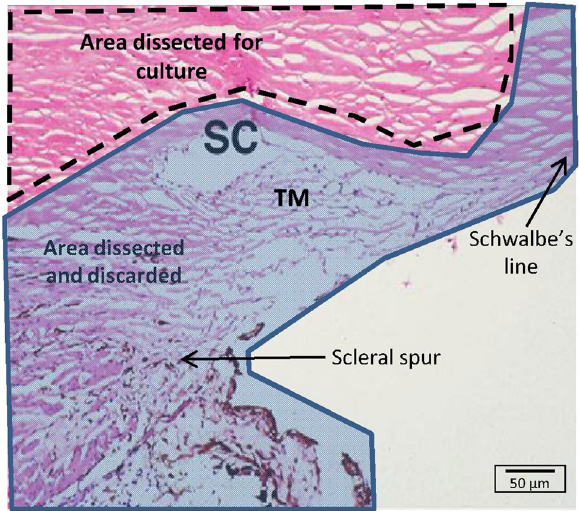
Figure 1. Establishing primary cultures of VDOP cells. Image showing the region of the conventional outflow pathway that was dissected and removed (lightly shaded portions), and the portion isolated (dotted area) for extracting VDOP cells. The extracted tissue rims were cut into 1–2 mm pieces, incubated in collagenase for 90 min and immersed in low glucose DMEM containing 10% FBS and 1% antibiotic/antimycotic on a gelatin- coated plate. Scale bar, 50 µm; SC, Schlemm’s canal; TM, trabecular meshwork.